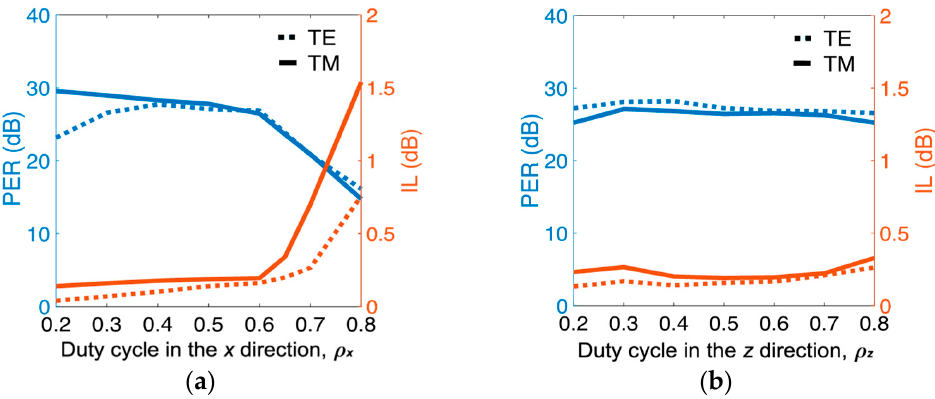
Figure 6. (left axis) PER and (right axis) IL of both modes as functions of duty cycles ( a ) ρ x and ( b ) ρ z at the same parameters as those in Figure 4.